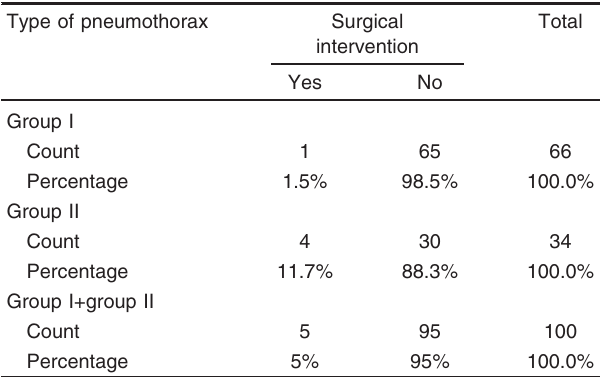
Table 7 Descriptive data of the surgical interventions in the studied patients Type of